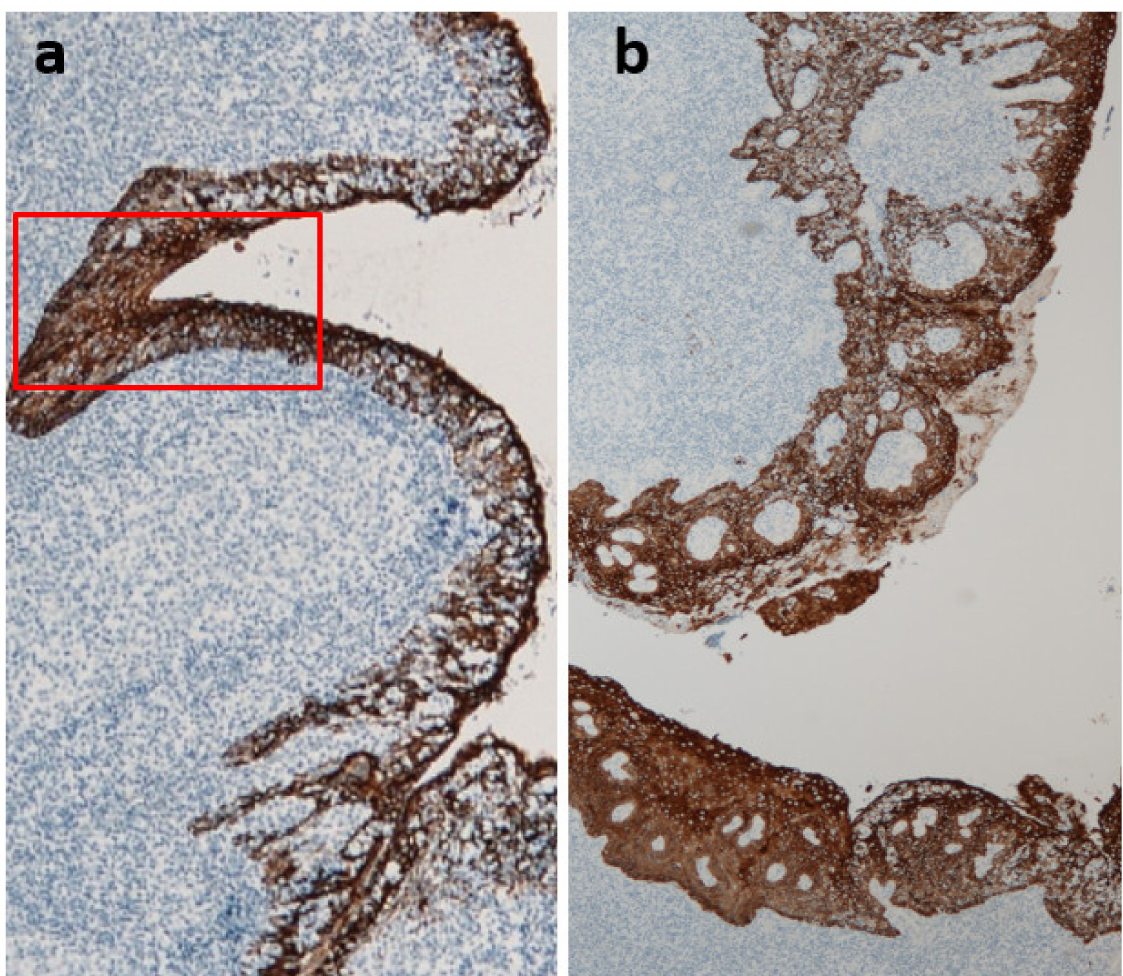
Figure 5. Reducing lymphoepithelial symbiosis and the progression of immunoglobulin A nephropa- thy (IgAN). The area of non-reticulated crypts (non-lymphoepithelial symbiosis areas) expands with the progression of IgAN. Representative cases: ( a ) CKD stage 2, disease period of 2 years, and ( b ) CKD stage 5, disease period of 30 years. The area of non-reticulated epithelia (red box) is restricted in the early stage of IgAN ( a ), whereas non-reticulation and squamous epithelialization are remarkable in ESKD IgAN ( b ). Stained with anti-cytokeratin antibody (brown), original magnification ×